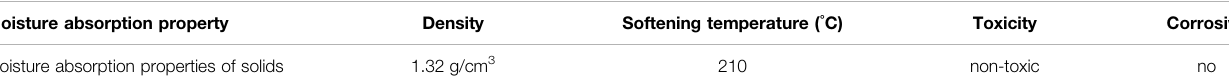
TABLE 3 | Mechanical properties of polyacrylamide.